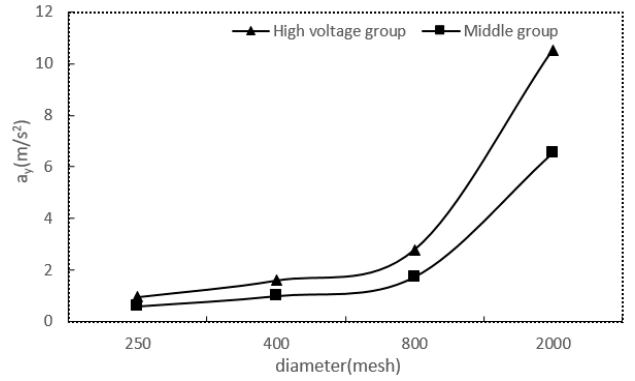
Figure 10. The calculated Y -axis acceleration.